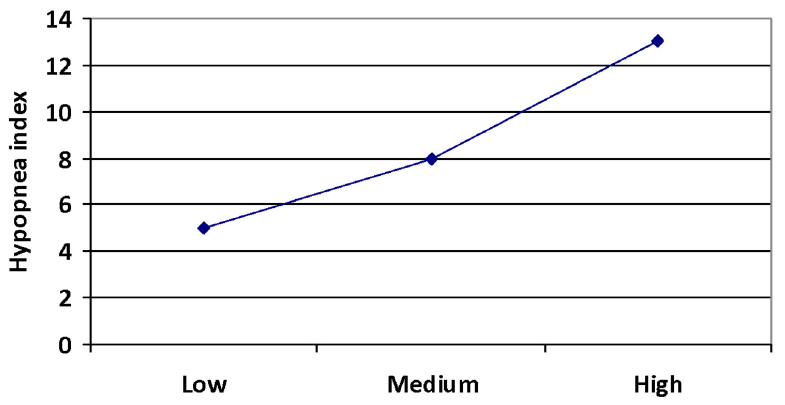
Figure 2. Hypopnea index (mean values) in the group with a low, medium, and high Fetuin-A